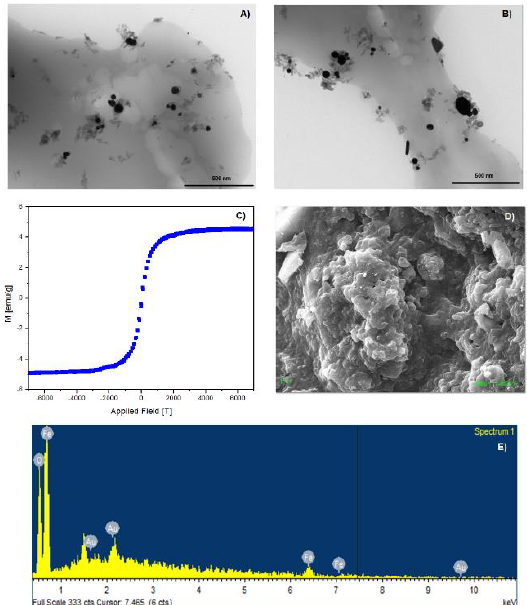
Figure 1. TEM; ( A , B ) VSM; ( C ) SEM; ( D ) and EDS; ( E ) analyses of NSs decorated with Fe 3 O 4 nanoparticles.